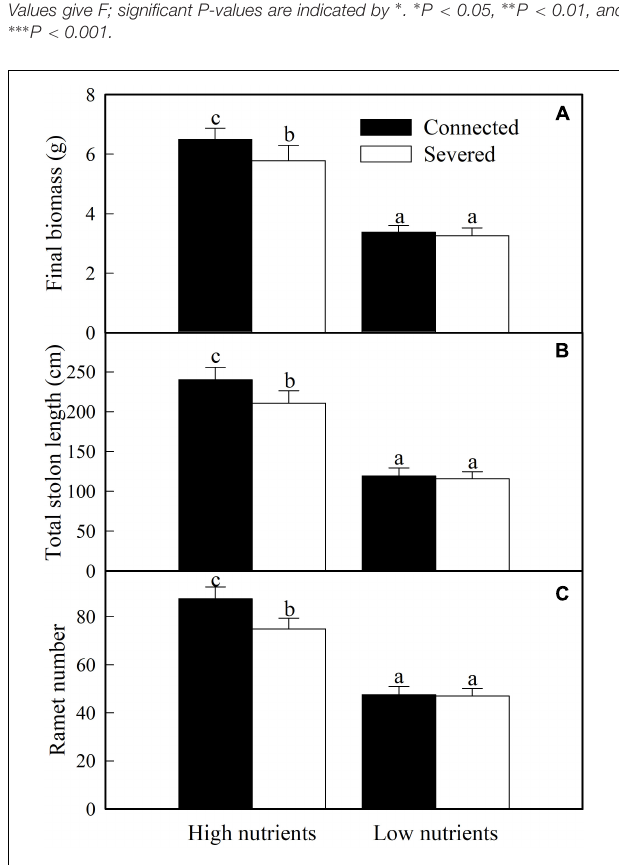
FIGURE 4 | Effects of experimental treatments on the final biomass (A) , total stolon length (B) , and ramet number (C) of the whole clonal fragment of A. philoxeroide . The data indicate the means + SE ( n = 8). The bars sharing the same letter are not significantly different at P =